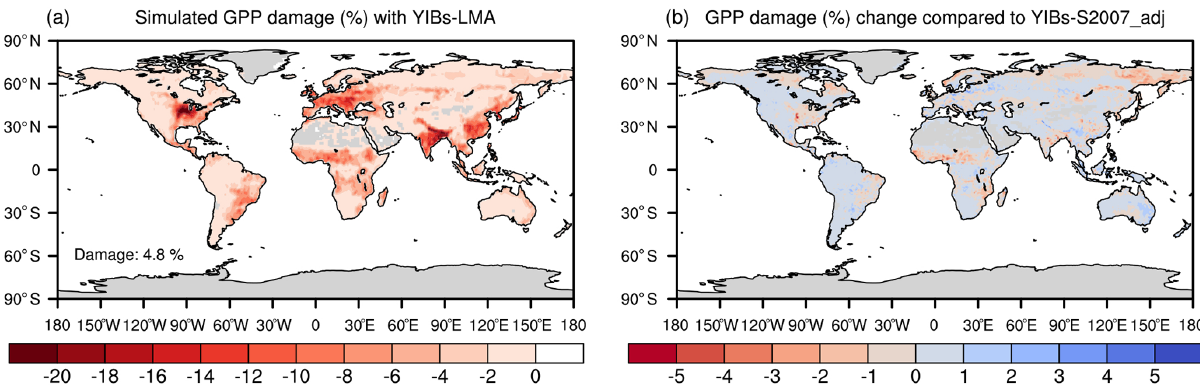
Figure 5. Global O 3 vegetation damage simulated with the LMA-based scheme. Results shown are the (a) GPP reduction percentages by O 3 simulated with the YIBs-LMA framework (gridded LMA from M2018, x = 0 . 019nmolg − 1 s − 1 , and a = 3 . 5nmol − 1 sg) and (b) their differences compared to the predictions from YIBs-S2007_adj simulation. Blue (red) patches indicate the regions where damage predicted in YIBs-LMA is lower (higher) than in